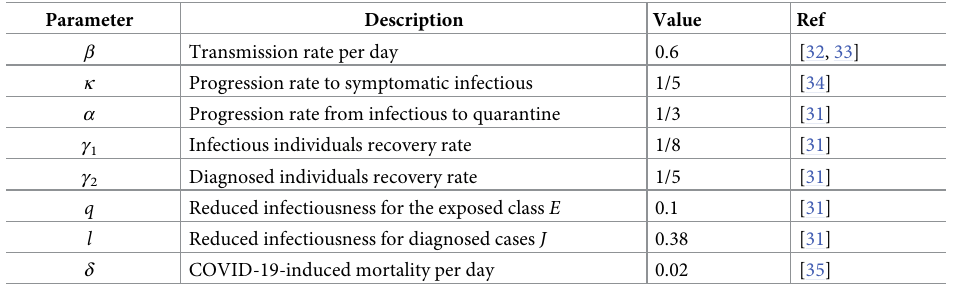
Table 1. Parameters of the single community COVID-19